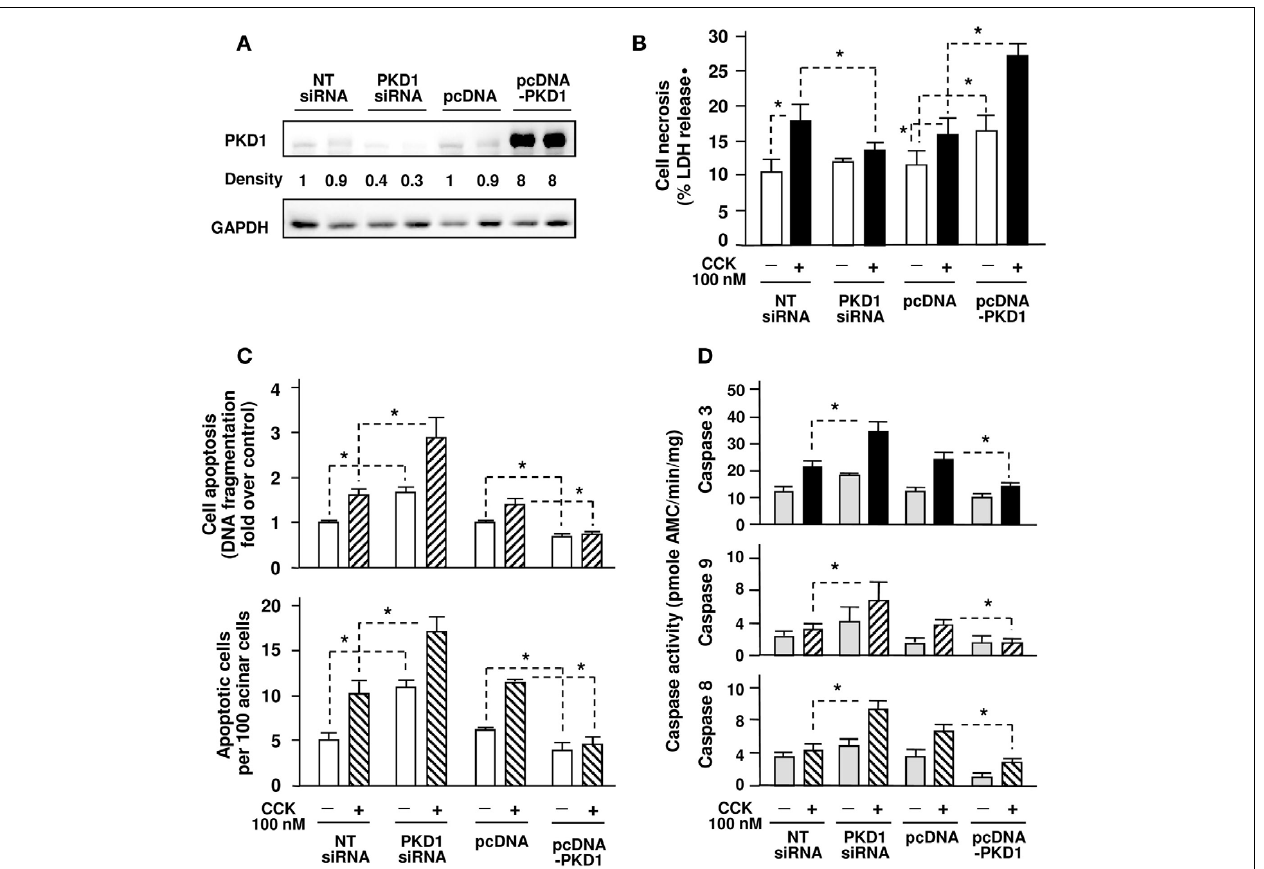
the percentage of total cellular LDH released into the extracellular medium. Results are expressed as the percentage of total cellular LDH released into the medium. (C) Apoptosis was quantified by two methods: Upper panel , measuring internucleosomal DNA fragmentation using Cell Death Detection ELISA Plus kit according to the manufacturer’s instructions. Results are expressed as increase fold over control in DNA fragmentation; Lower panel , the transfected AR42J cells growing on glass coverslips were fixed and apoptosis was measured by the percentage ofTUNEL staining positive cells. For each condition, at least 3000 cells were counted. (D) Caspase activities were measured as described in Section “Experimental Procedures.” Graphs (B–D) show means ± SE ( n = 3–5) for each condition. * P < 0.05 versus corresponding controls (NT siRNA or pcDNA3) as